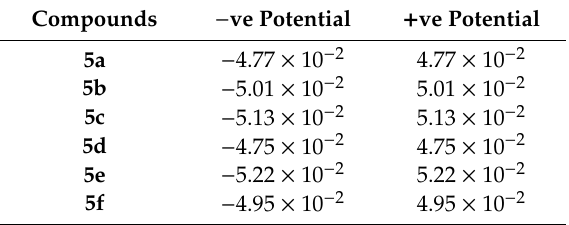
Figure 2. Molecular electrostatic potential surfaces of compounds ( 5a – f ), the electronic density in red represents nucleophilic sites and in blue represents electrophilic site. Table 4. Molecular electrostatic potential (MEP) values of all compounds ( 5a – f ).